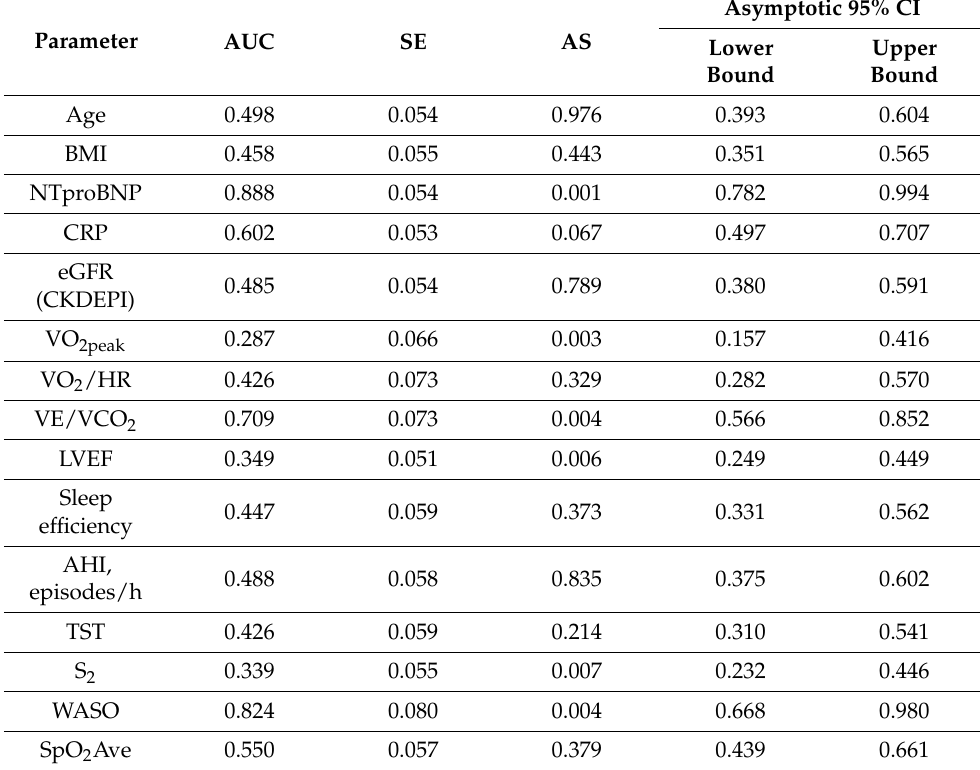
Table 3. ROC-curve analysis of clinical, laboratory and instrumental